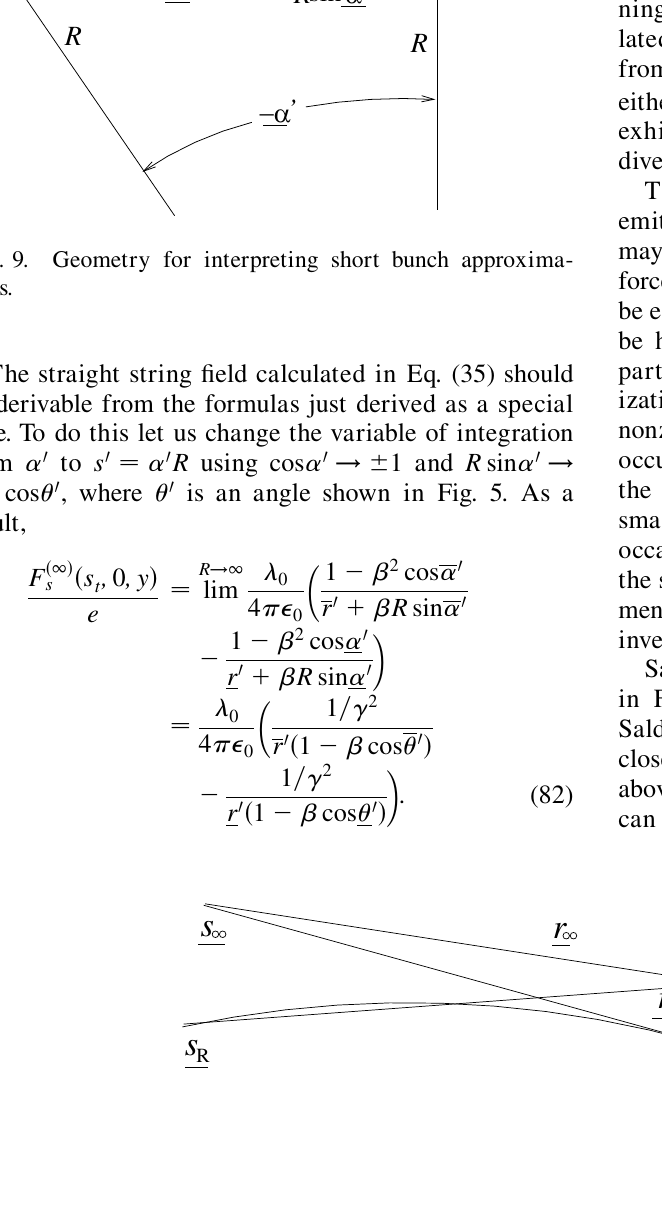
FIG. 10. Superposition of straight line and curved charge distribution for the purpose of renormalizing the self-force due to the curvature of the path. At each point P the renormalized force G is obtained by subtracting the tangentially matched straight line force F (cid:2)1(cid:3) from the curved line force F (cid:2) R (cid:3) .